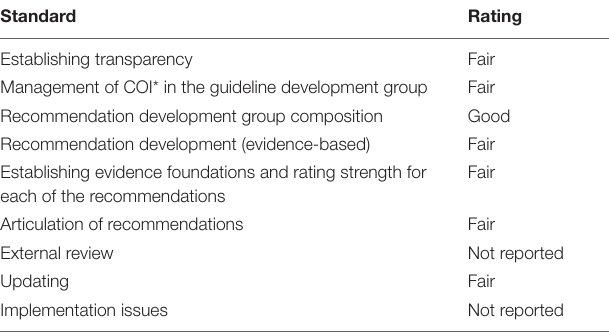
TABLE 1 | Recommendations